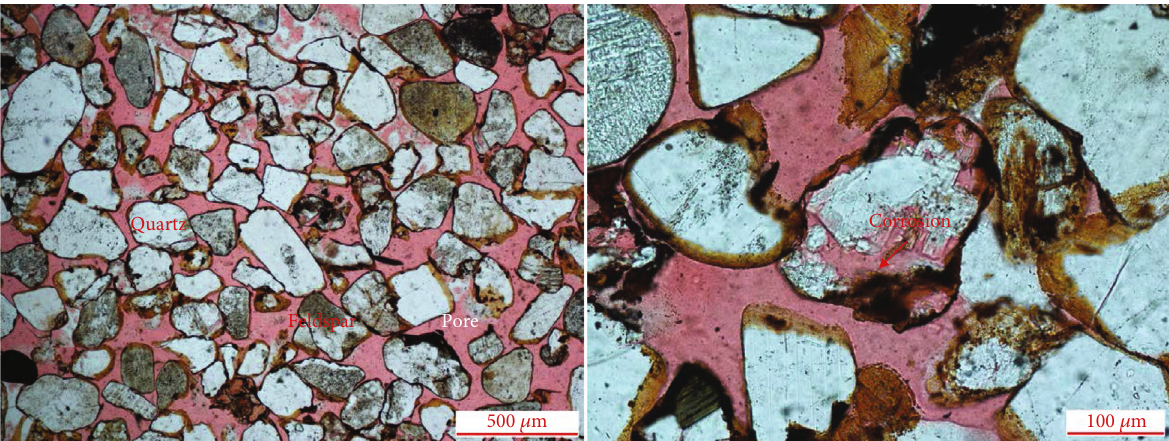
Figure 4: Thin sections of sandstone cores from HLS.